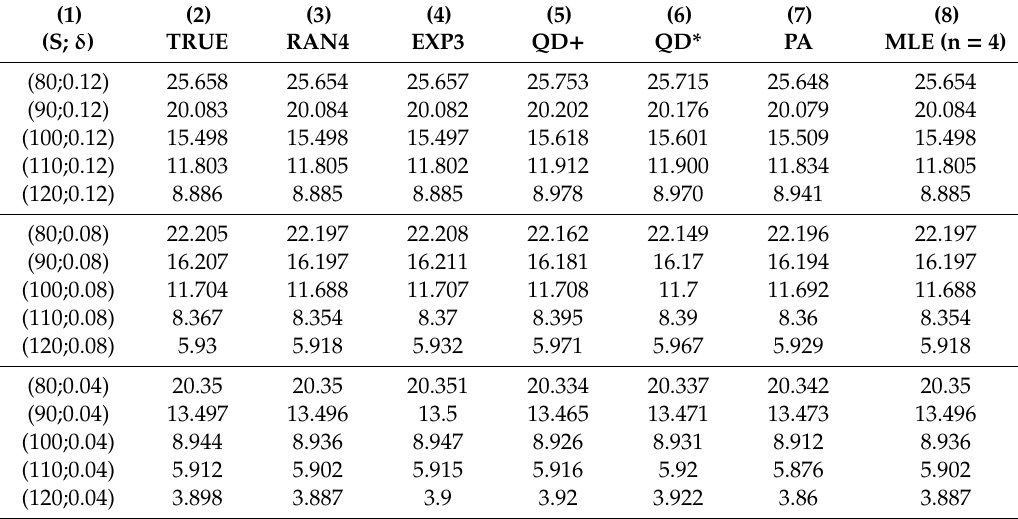
Table 1. Comparison of American put option values ( τ =